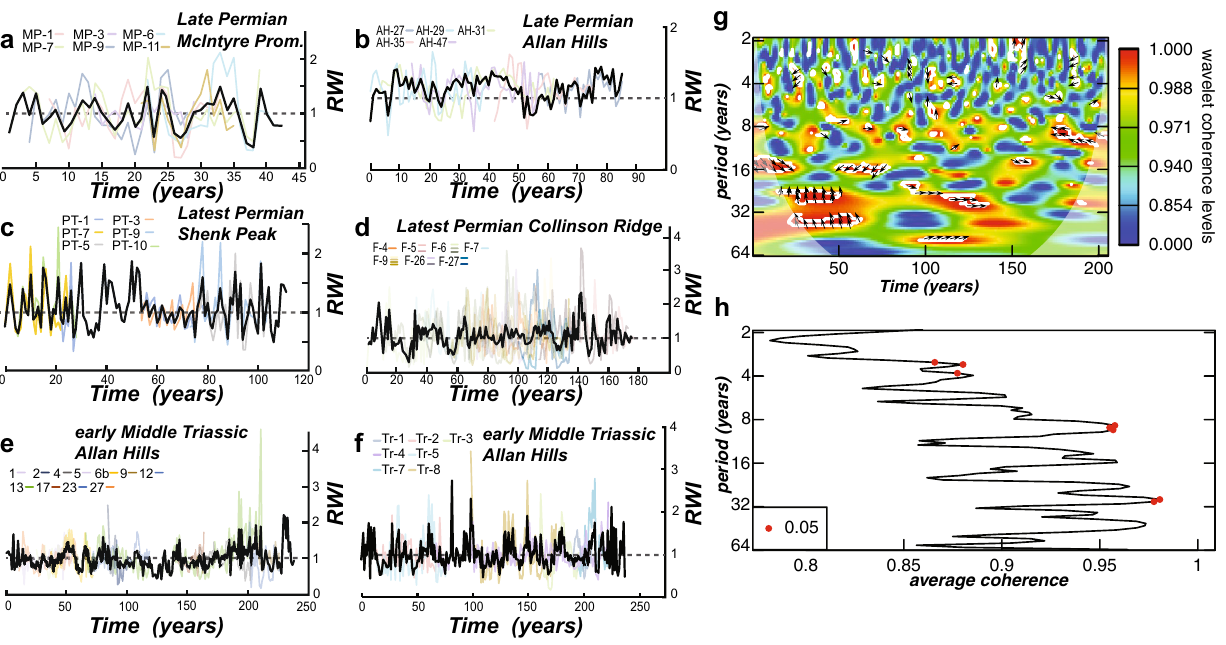
Figure 3. Ring width index (RWI) and correlation of the replicate early Middle Triassic chronologies ( g – h ). ( a – f ), RWI plots of cross-matched tree ring width data. ( g ) Wavelet scalogram of wavelet coherence between the two replicate Triassic chronologies: color spectrum is equivalent to the correlation of the two chronologies (0–1); the arrows indicate positive (pointing right) or negative correlation (pointing left); the up/down direction of arrows indicates if one chronology leads/lags another, respectively (irrelevant for this analysis as the two chronologies are not cross-matched to each other); white lines indicate the 0.05 significance level of wavelet coherence. ( h ) Fourier period versus average wavelet coherence, the red dots signify Fourier periods significant at the 0.05 level for the specified wavelet correlation between the two chronologies. Figure created using Adobe Illustrator, v. 25.0.1,